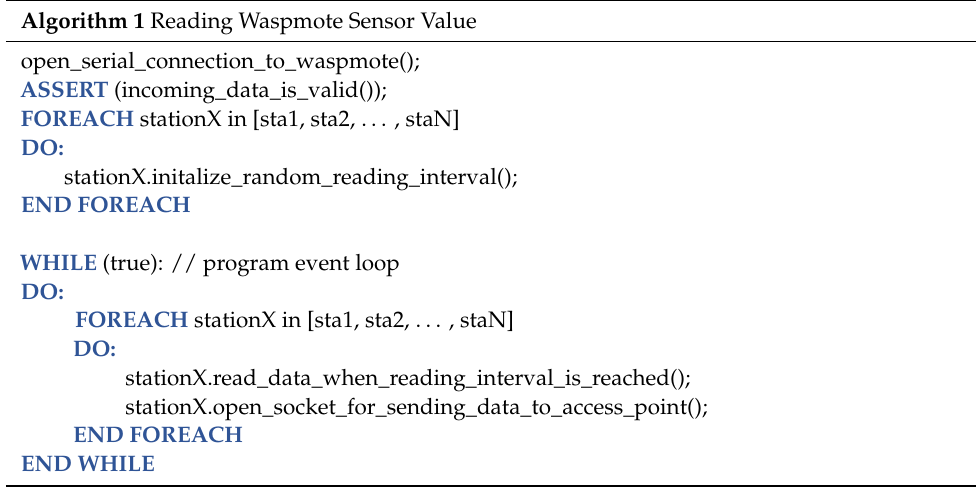
Algorithm 1 Reading Waspmote Sensor Value